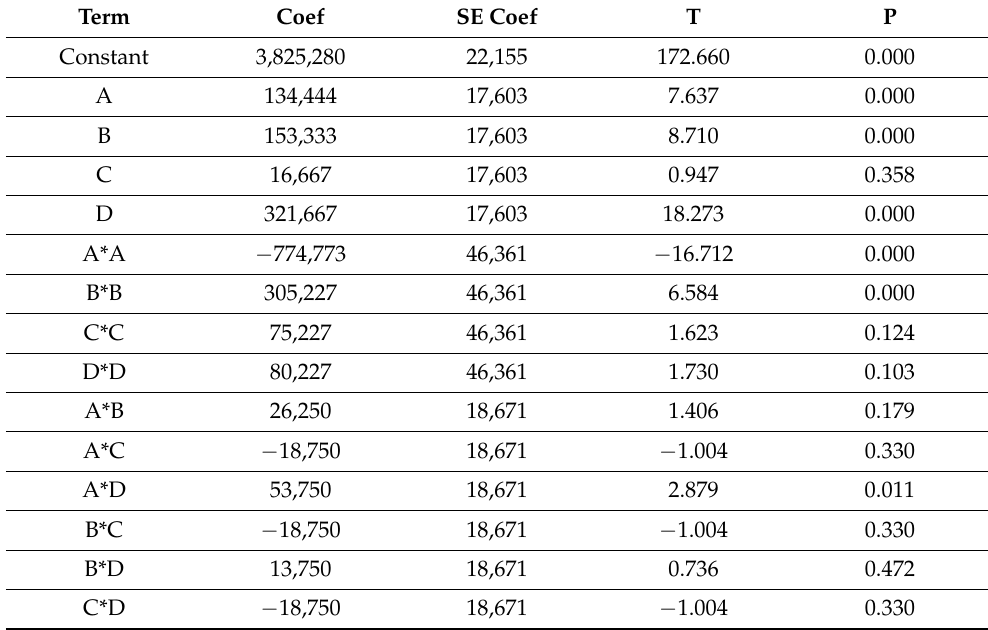
Table 10. Estimated Regression Coefficients for Electrical Conductivity ( Ω − 1 m − 1 ). Term